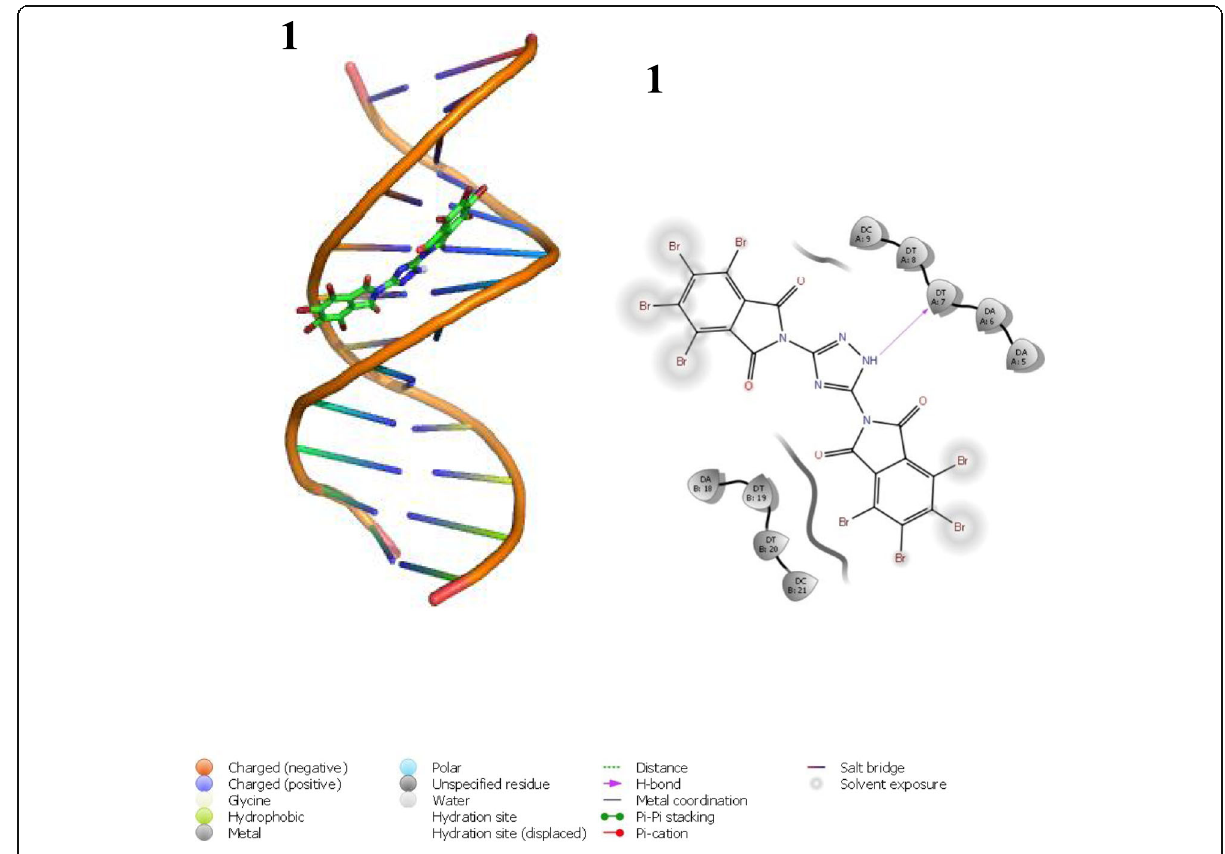
Fig. 4 Molecular docking study of the compound